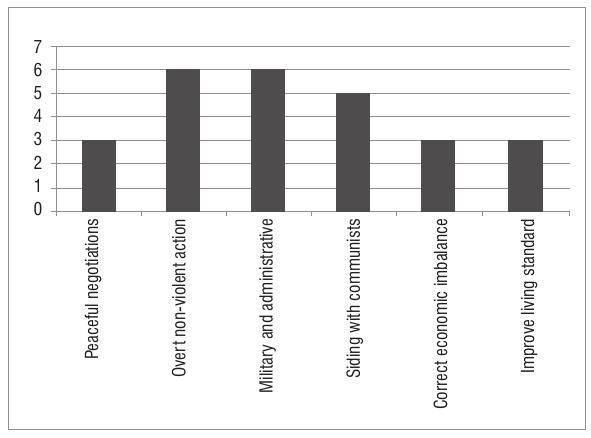
Figure 1: Number of occurrences of themes supporting hope.